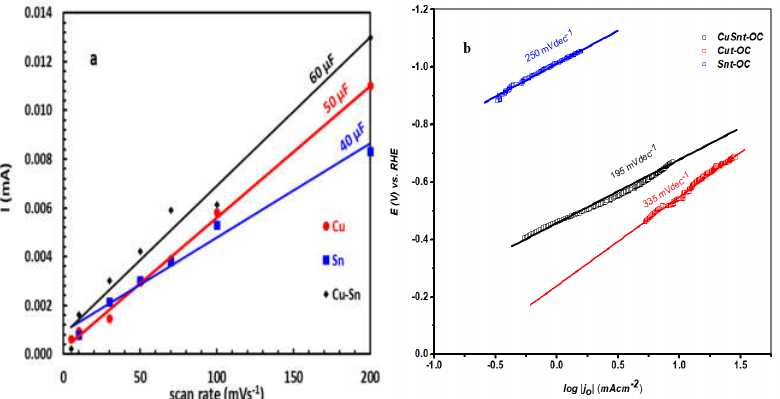
Figure 10. ( a ) Anodic charging current measured at the potentials of 0.5 V vs. RHE plotted as a function of the scan rate and the slope of the linear fit giving the C dl . ( b ) Tafel analysis of the catalysts in 0.1 M KOH.